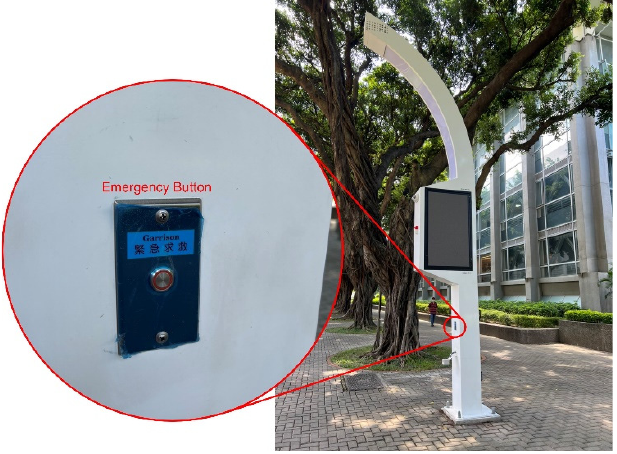
Figure 2. Smart lamp with emergency button.